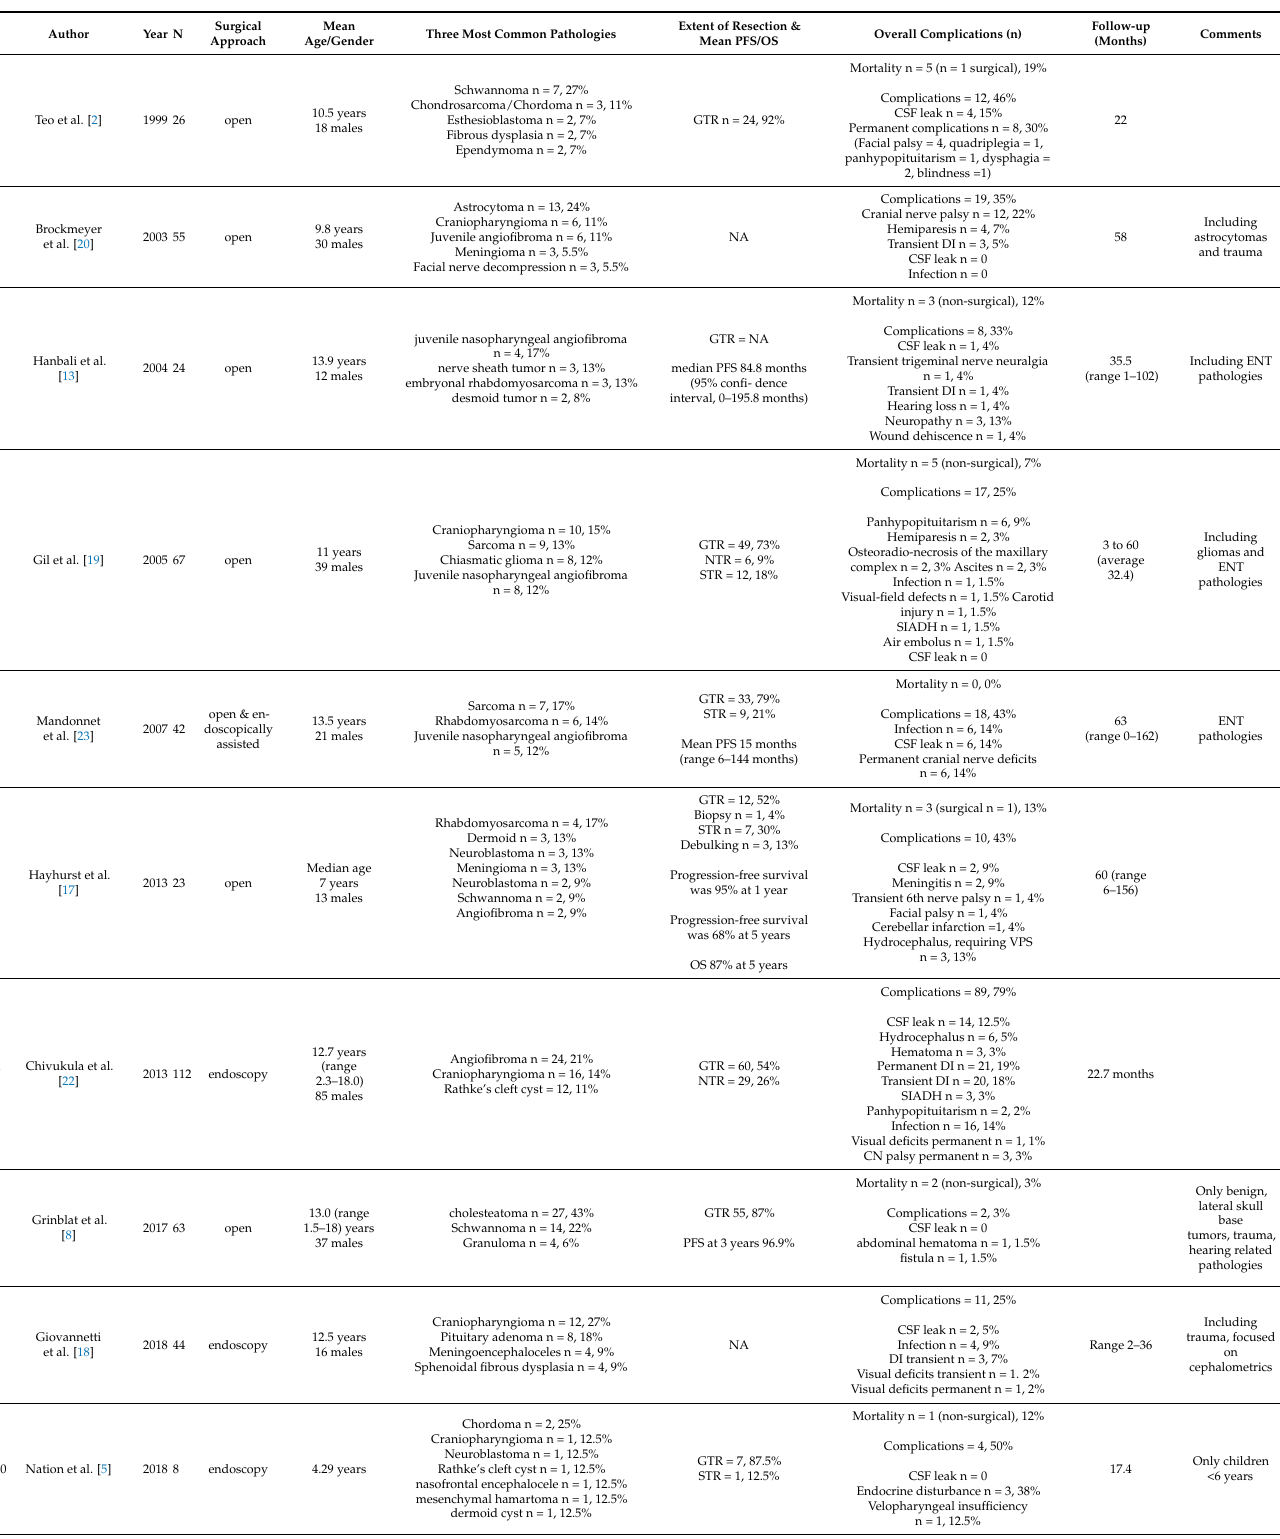
Table 3. Results from systematic review of other case series about pediatric skull base